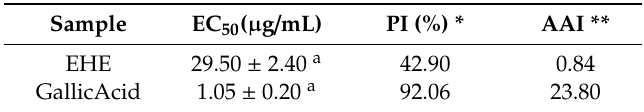
Table 2. Antioxidant activity of the hydroethanolic extract and fractions of B. virgilioides as determined by reducing the free radical 2,2-diphenyl-1-picrylhydrazyl (DPPH • ).